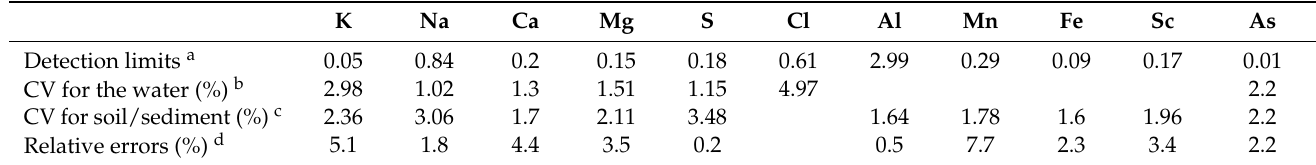
Table 1. The detection limits, precision, and accuracy of various elements in the samples.